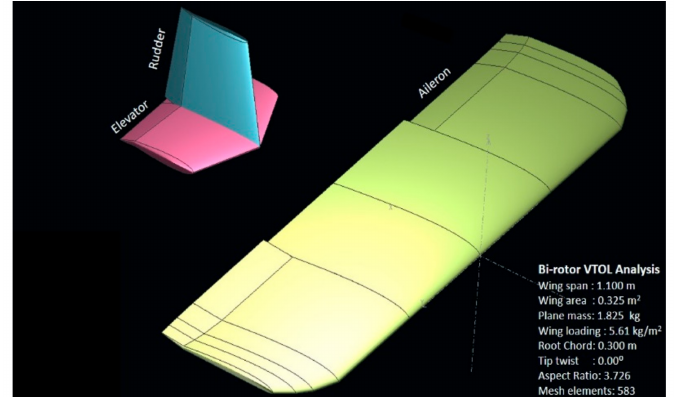
Figure 10. Hybrid VTOL tilt-rotor modeled in XFLR.